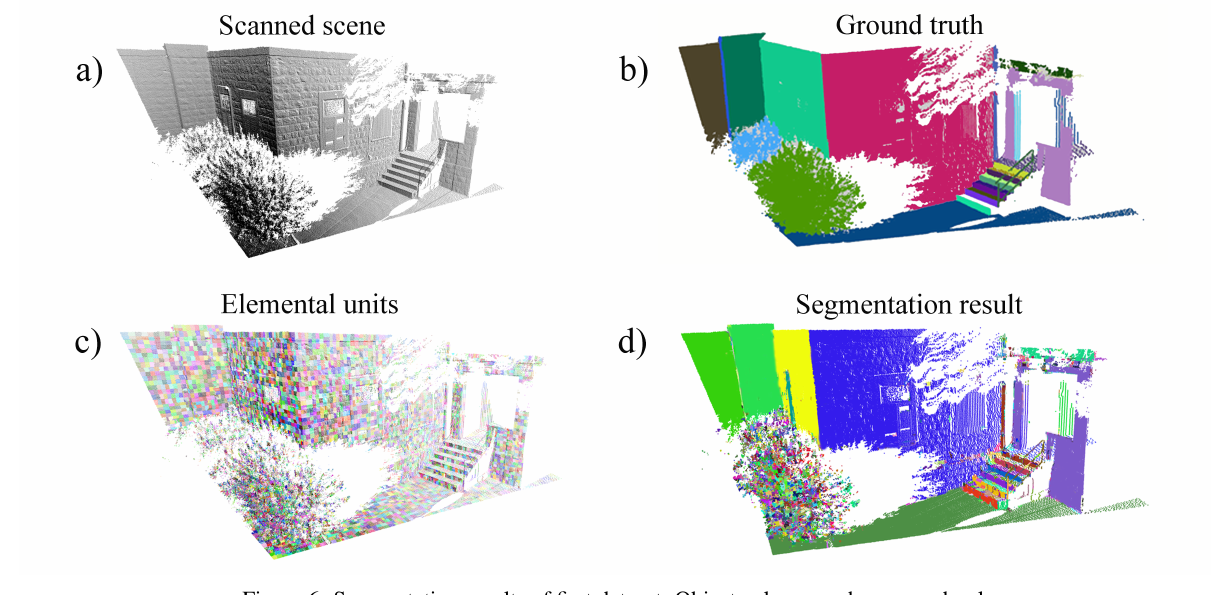
Figure 6: Segmentation results of first dataset. Object colors are chosen randomly